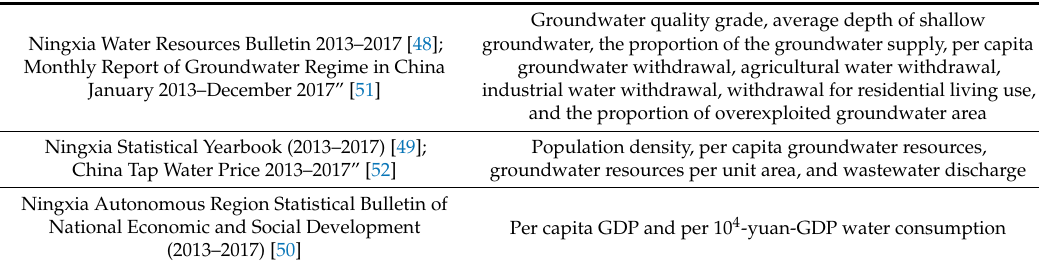
Table 2. The sources of the